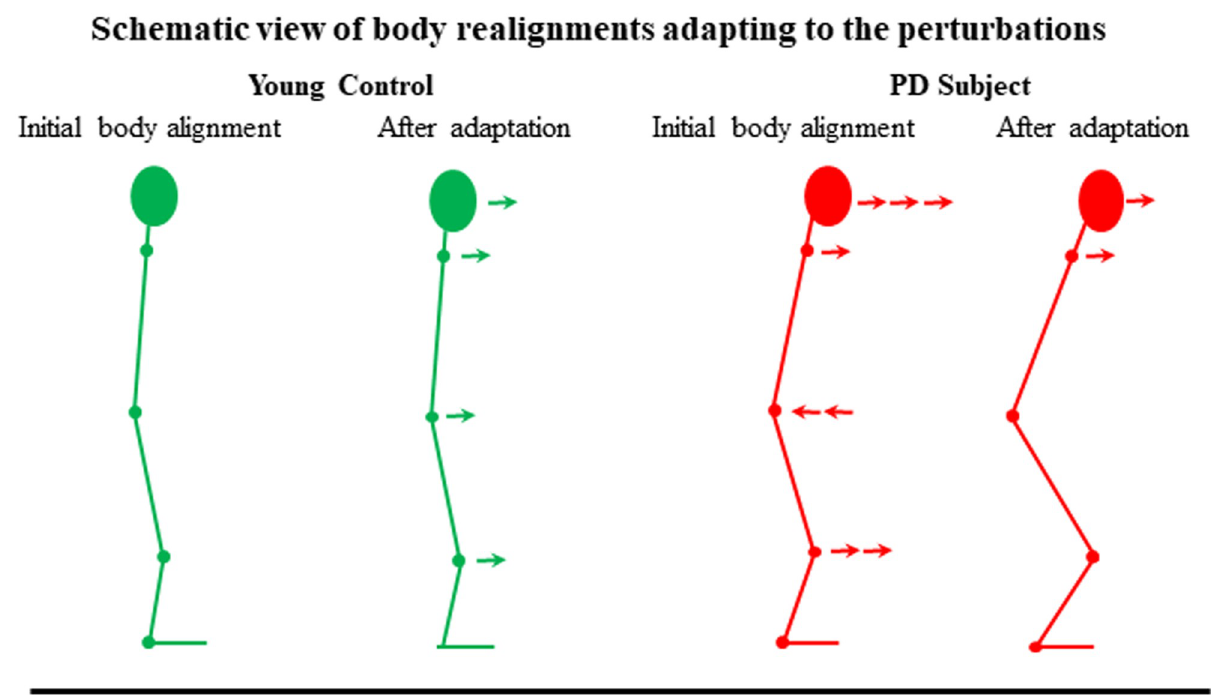
Fig 2. Schematic image of the changes of posture. The figure illustrates the typical posture of young controls and of patients with PD in DBS OFF (both with eyes closed and eyes open). During balance perturbations, young controls increased their leaning forward involving all body segments. In patients with PD with DBS OFF, the posture was deformed as compared to young controls by an increased knee bending, that the hip was more backward and that the head was particularly positioned more forward. During balance perturbations, the PD subjects increased the leaning forward of the shoulders and